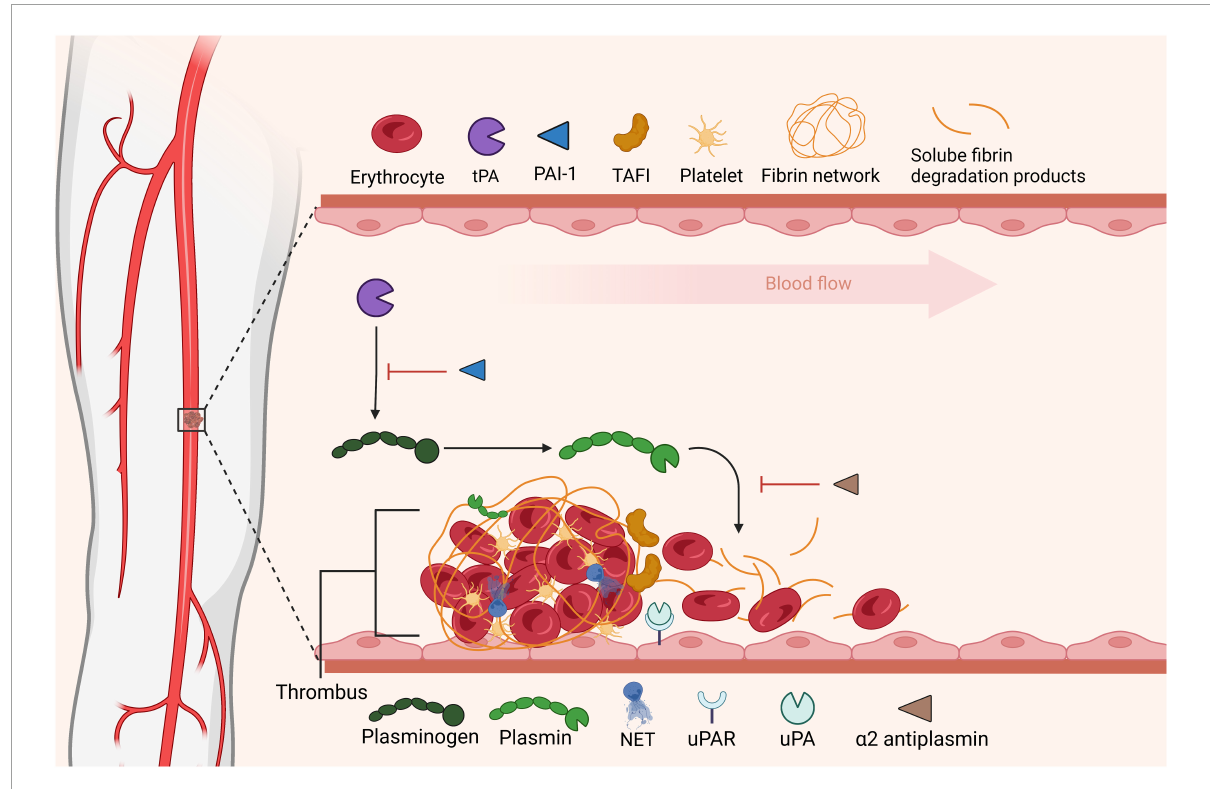
FIGURE2 Fibrinolytic dissolution of thrombi. Fibrinolysis is initiated by plasminogen activators that convert circulating plasminogen to its active form plasmin promoting degradation of fibrin. Soluble fibrin degradation products can be cleared from the circulation. Fibrinolysis is regulated at the level of plasminogen activation, via plasminogen activator inhibitor-1 (PAI-1) or by direct inhibition of plasmin by α 2-antiplasmin ( α 2AP). Thrombin activable fibrinolysis inhibitor (TAFI) impedes fibrinolysis by removing C-terminal residues from fibrin, these lysine residues are vital for plasminogen binding to fibrin. In this figure was adapted from “Tissue Plasminogen Activator Activity at Ischemic Region in the Brain,” by BioRender.com (2022). Retrieved from